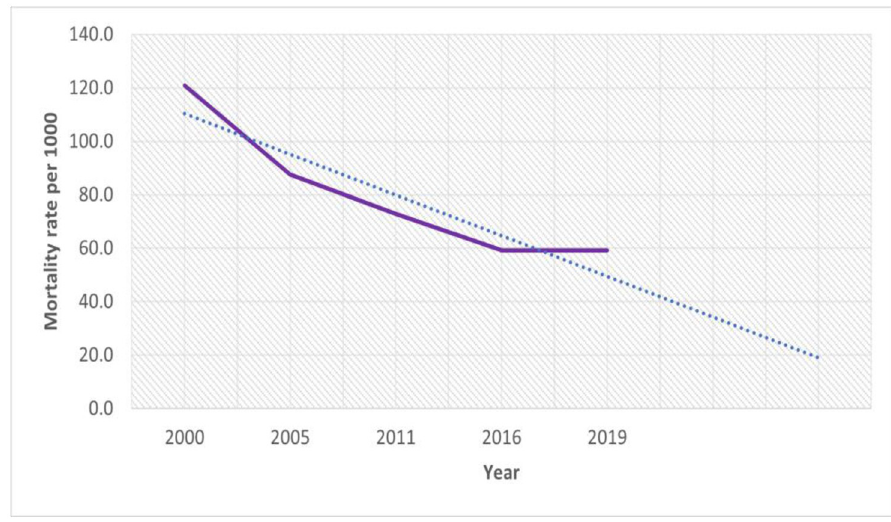
Fig 1. Trends of under-five mortality rate in Ethiopia from